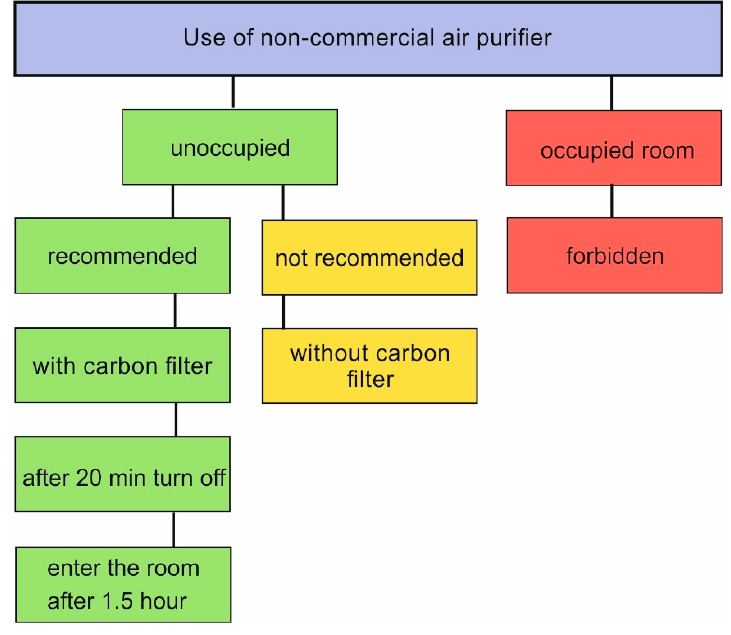
Figure 7. The scheme with maintenance instruction of non-commercial air purifier.